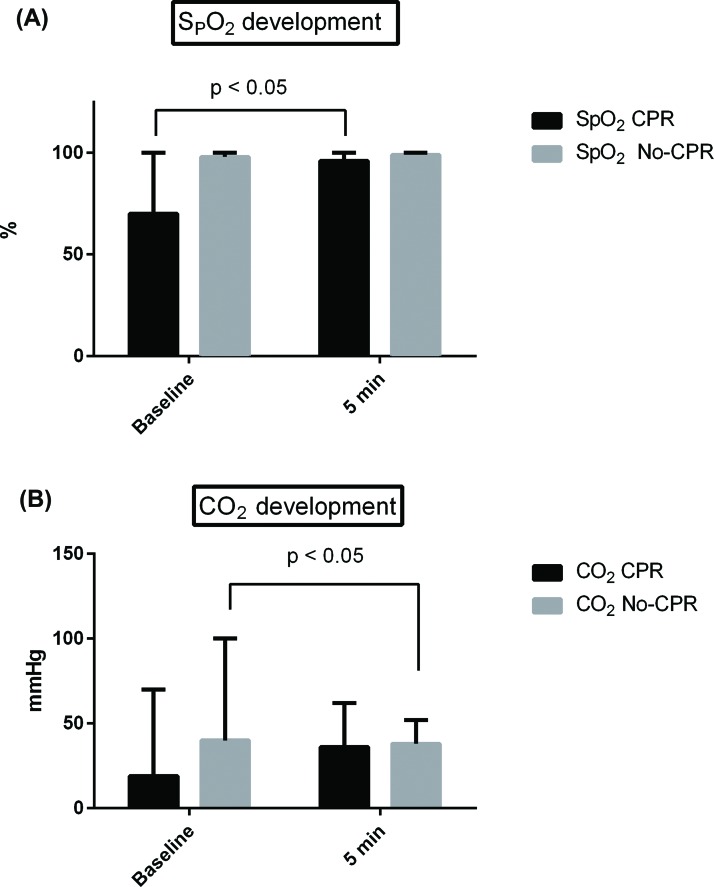
(A) SpO2 development and (B) CO2 development within the first five minutes in patients with CPR and without CPR.